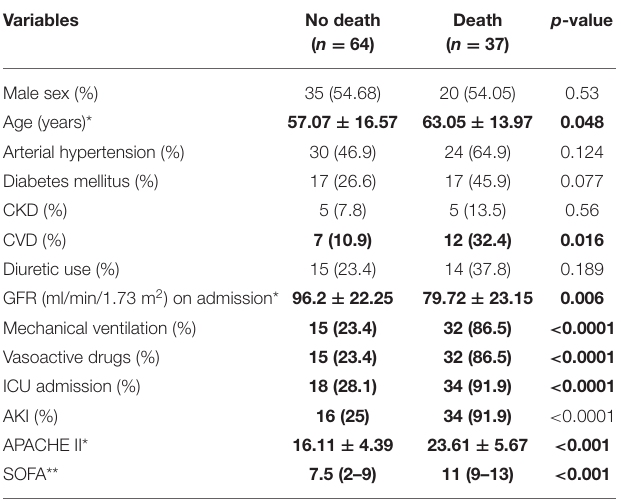
TABLE 3 | Logistic regression of variables associated with AKI and death in hospitalized patients.